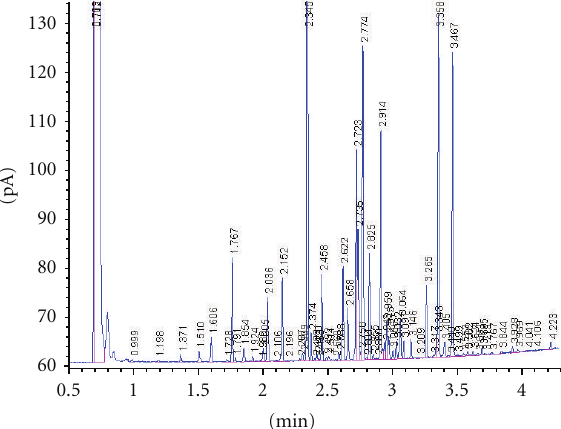
Figure 2: Gas chromatographic methyl ester profiles of endophytic Sporosarcina aquimarina